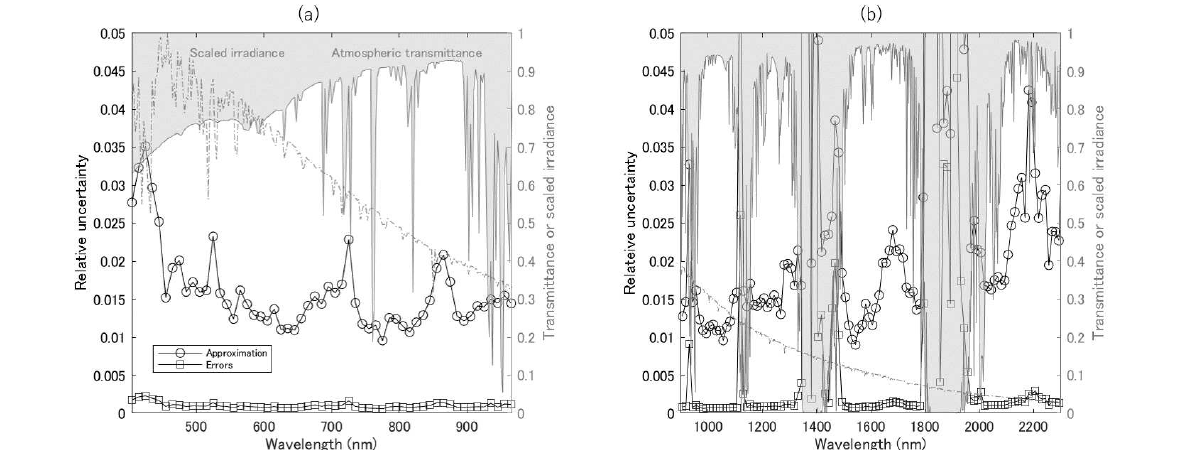
Figure 6. ( a ) Plot of the uncertainty approximation in the relative values using the derived equation (Equation (16)) for the HISUI VNIR band region. The absolute differences between approximated and simulated uncertainties in the relative values are also shown. ( b ) Plot of the approximated uncertainties and absolute errors between approximated and simulated uncertainties in the relative values of the HISUI SWIR band region ( < 2300